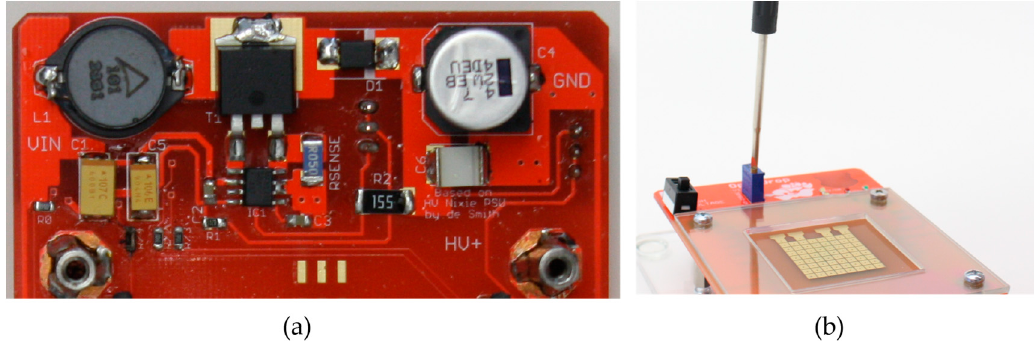
Figure 8. ( a ) Integrated power supply that steps up the voltage from 12 V to 260 V DC; ( b ) The user adjusts the voltage to fit the EWoD requirements for the targeted fluid.